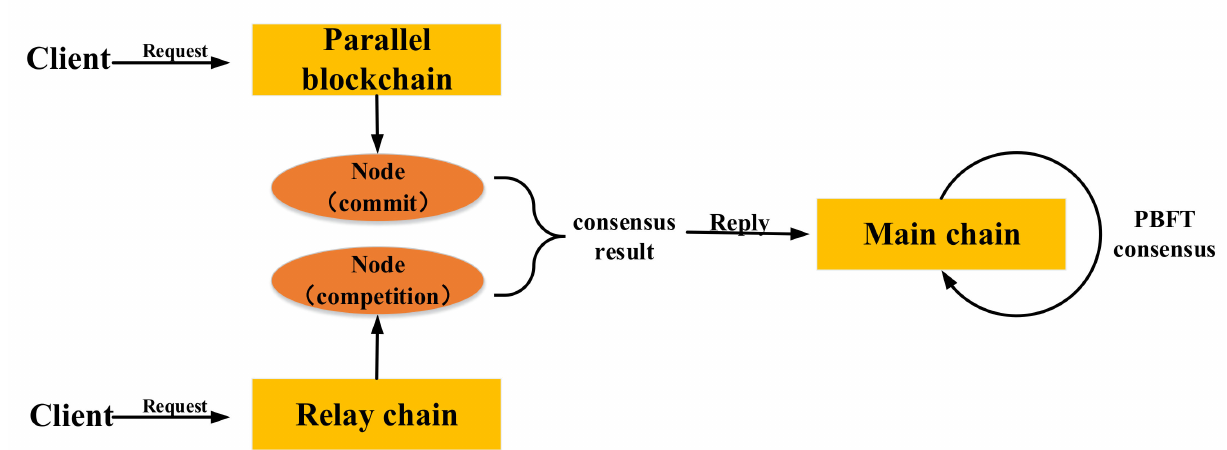
Figure 6. Schematic diagram of SPBFT consensus